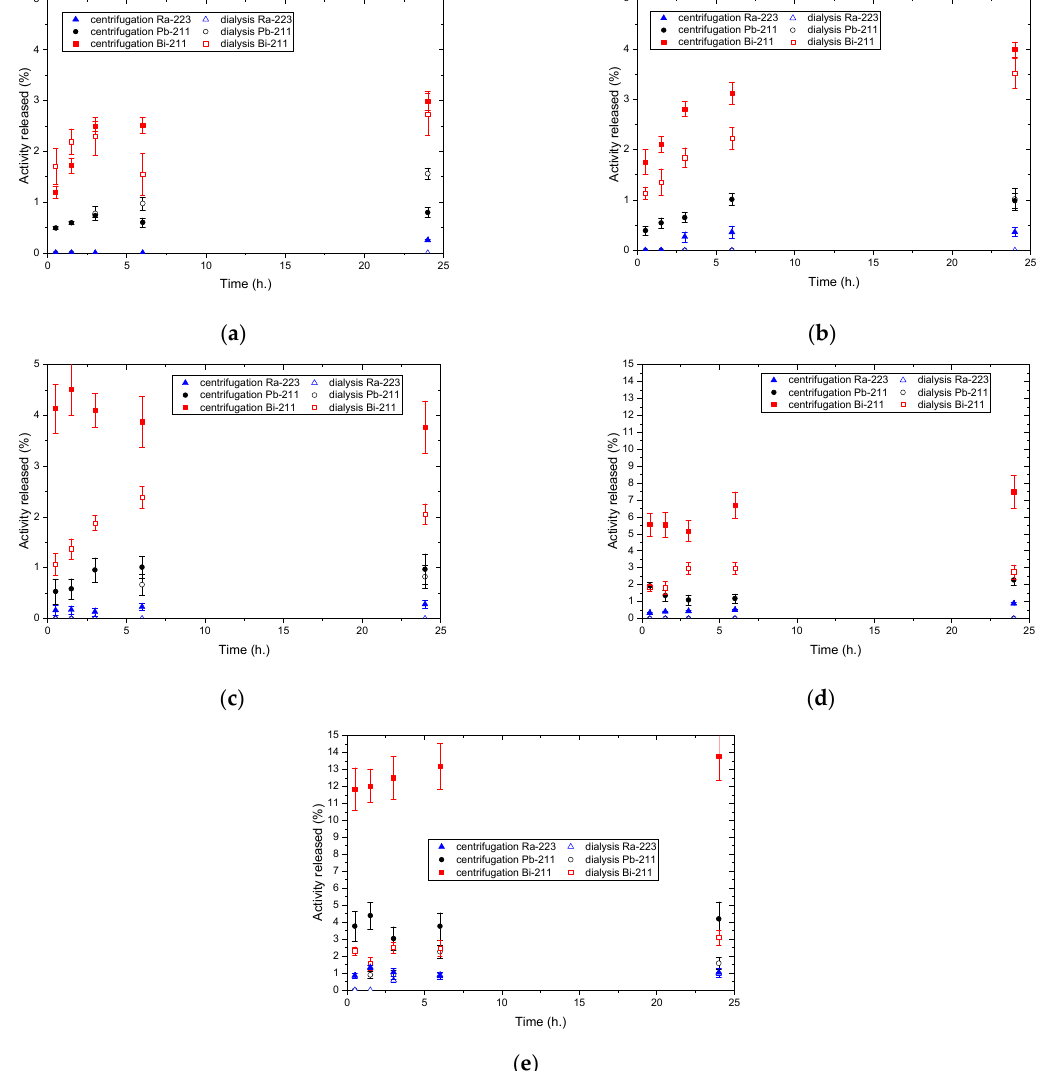
Figure 2. Nuclides release vs. time at ( a ) 1 mg/mL, ( b ) 100 µg/mL, ( c ) 50 µg/mL, ( d ) 25 µg/mL, ( e ) 10 µg/mL dispersion concentration using centrifugation and dialysis as phase separation methods.